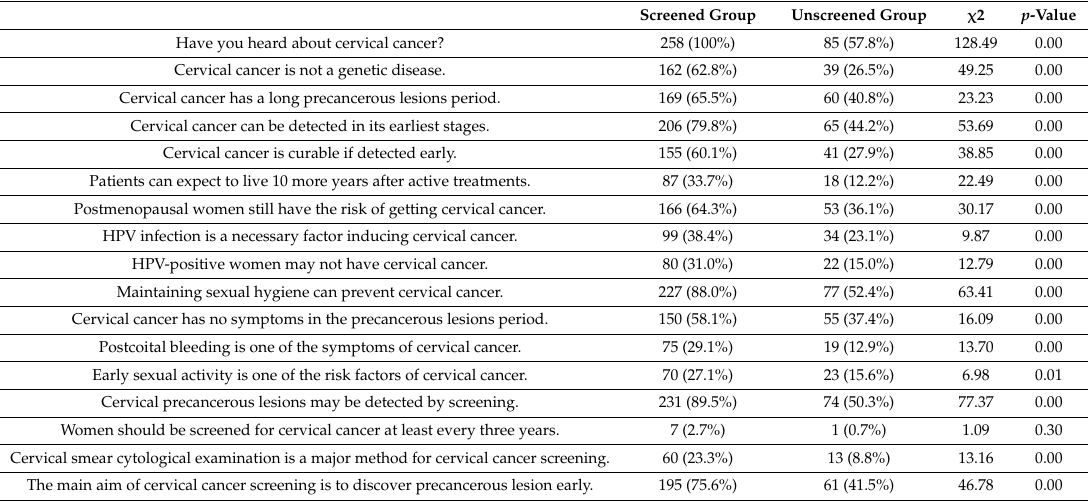
Table 3. Related knowledge of cervical cancer and its screening among rural women of screened and unscreened groups, n (%).